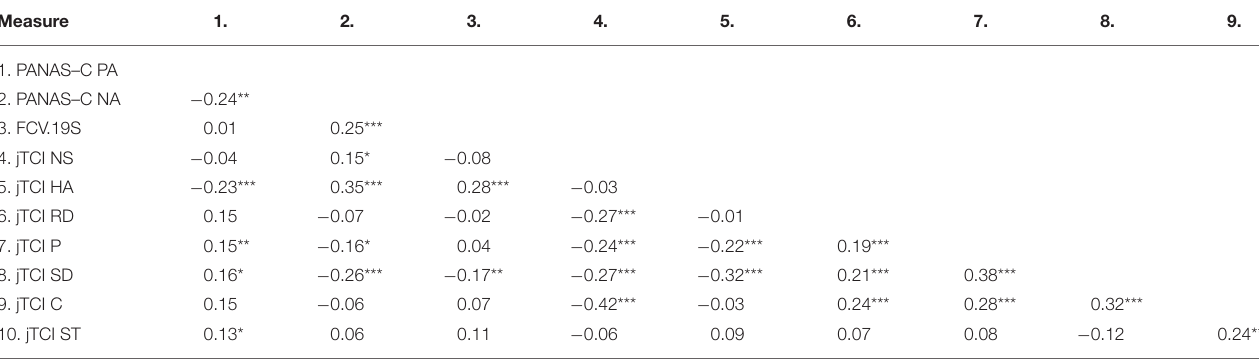
TABLE 5 | Correlation matrix of the PANAS-C, FCV-19S and jTCI scores obtained during the COVID-19 pandemic (October-Novembre 2020). Measure